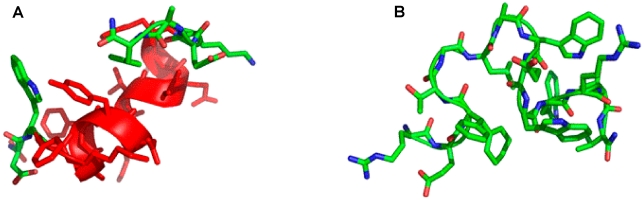
Molecular illustration of the structure of D-4F (A) and OxP-11D (B) after 83 nsec of molecular dynamics in HFIP:aqueous buffer 6∶4, v:v environment.α-helical segments are in red ribbon, disordered and turn segments are in green highlight The N-terminus is at the lower left and the adjacent C-terminus is in the upper right of the figure.